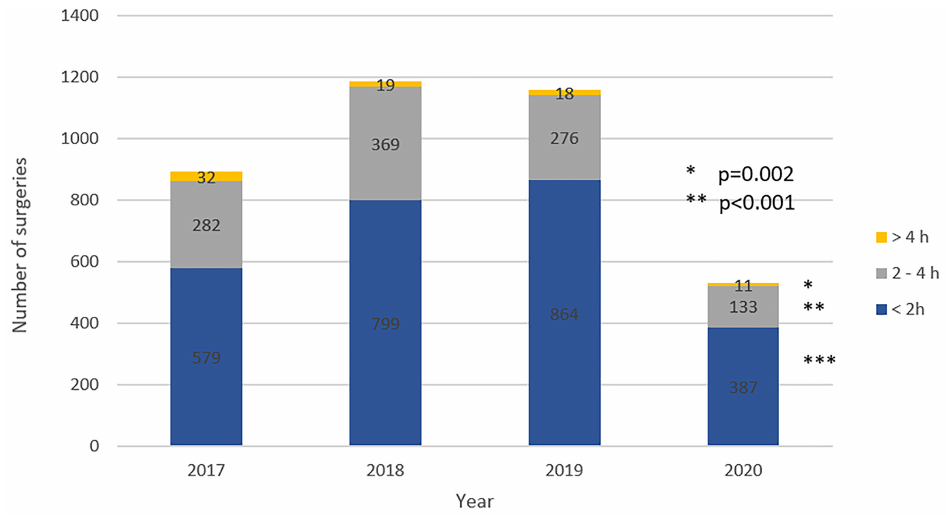
Figure 2 - Comparison of surgical volume categorized by OR time from February 27th to May 30 th .